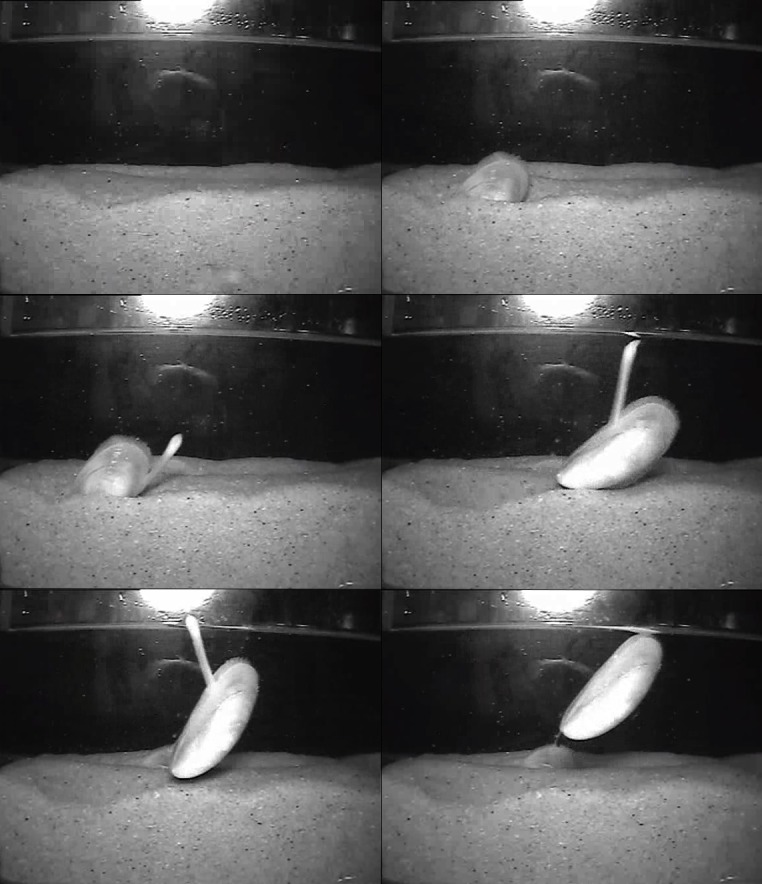
M. edulis emergence from burial.Still images from video footage (filmed under infra-red light) showing the emergence of M. edulis from sediment burial over the course of several hours at night. The foot was laying byssus threads on the sediment and on the vertical (glass) surface.